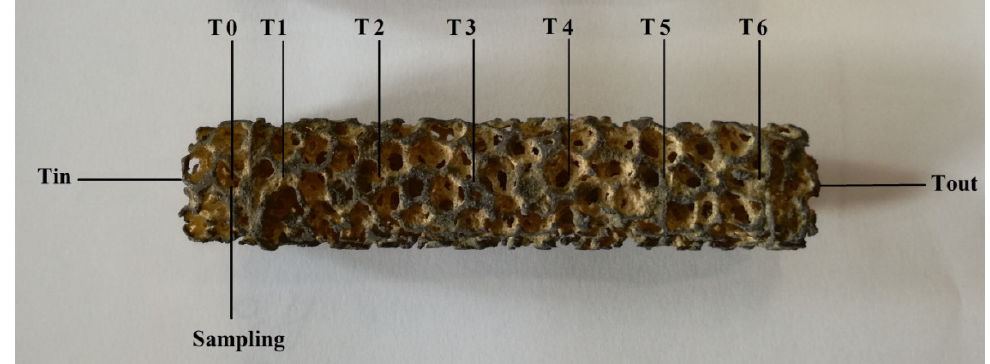
Figure 4. Schematic representation of the sampling of the temperatures over the catalytic bed.